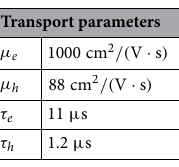
Table 1. Carrier transport parameters for electrons and holes for spectroscopic CZT by Redlen 25 .